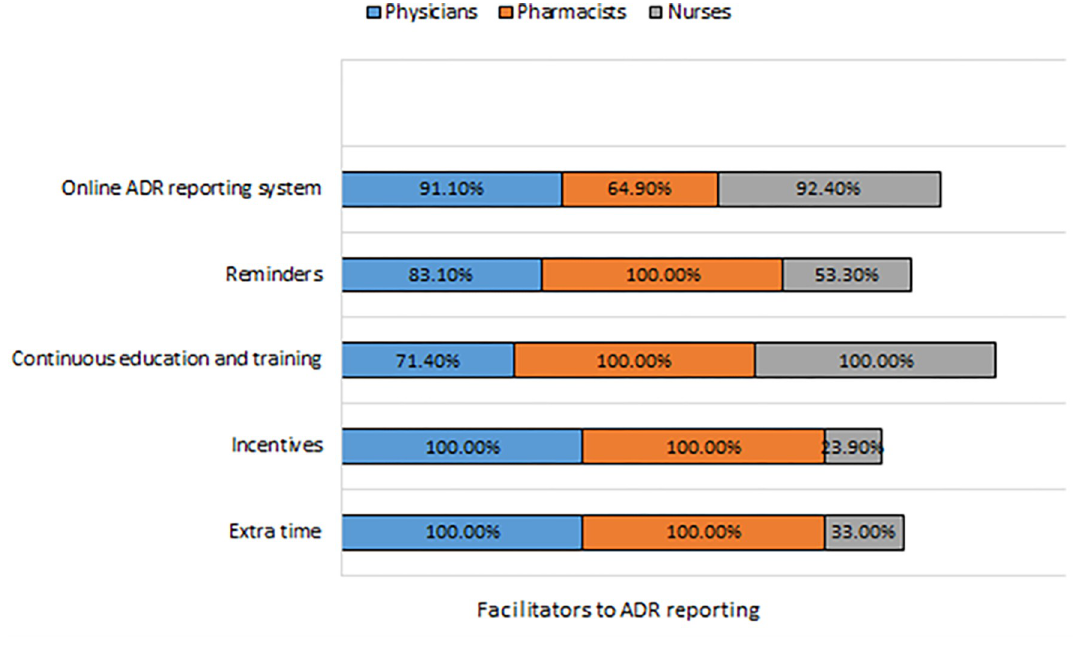
Fig 3. Facilitators to ADR reporting by